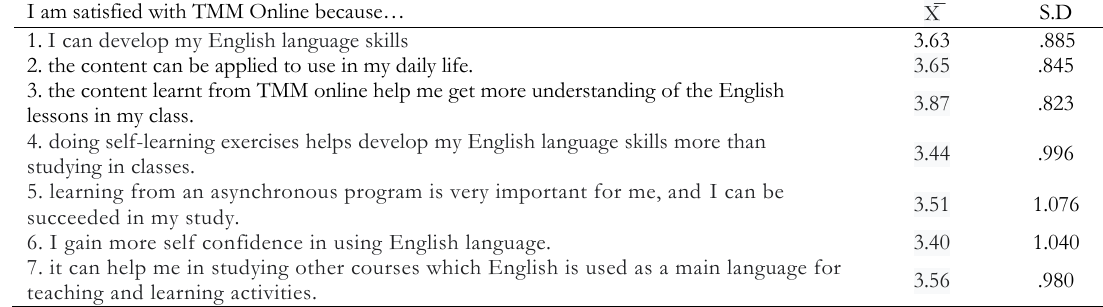
TABLE 5 . Attitude towards doing self-study using TMM Online focused on knowledge